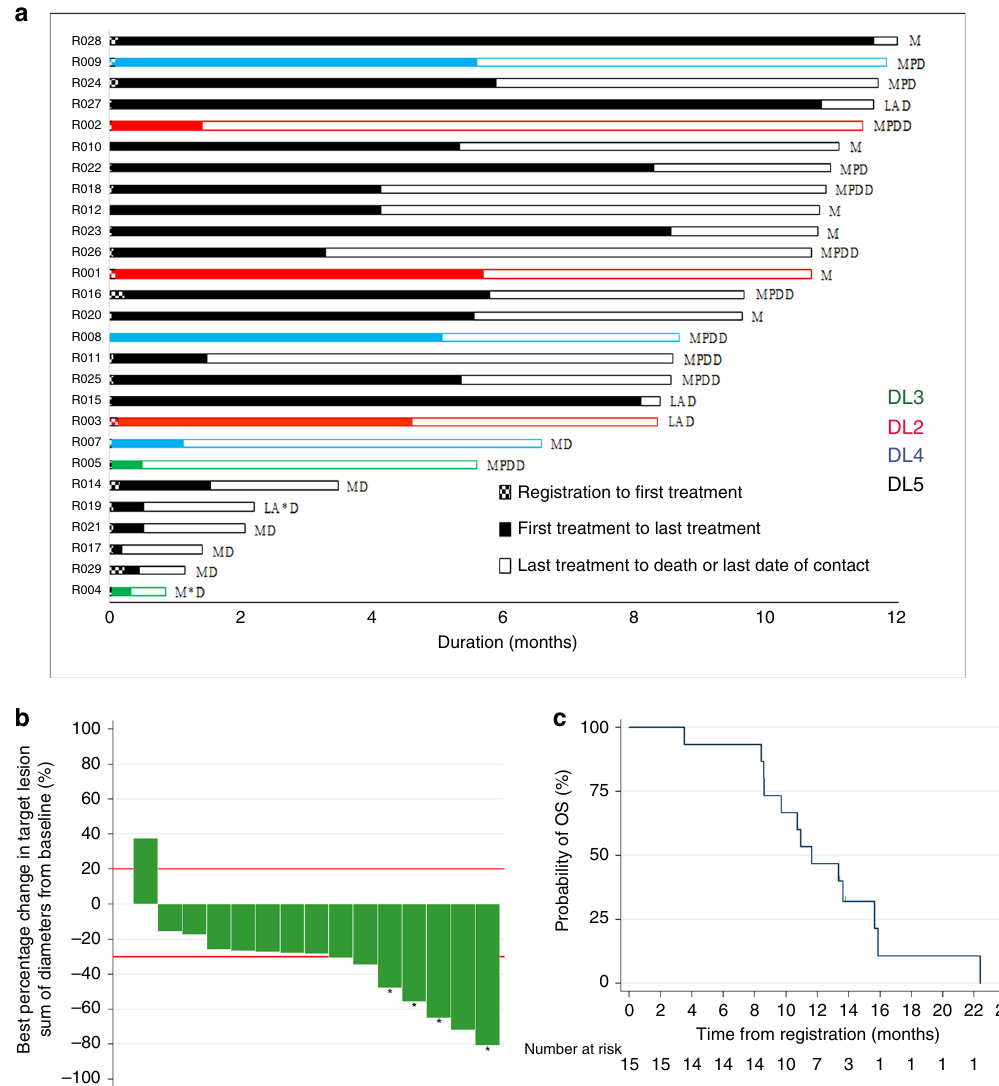
Fig. 2 Primary and secondary endpoints for STARPAC clinical trial. a Swimmer ’ s plot with color code for different dose levels (DL) and duration (months) on X -axis along with type of disease: locally advanced (LA) and metastatic (M), those who experienced DLT (*) and disease status (Death (D), progressive disease (PD)) censored at the pre-speci fi ed 12 months of starting on the trial. b Waterfall plot of best percentage change of sum of diameters in target lesion from baseline in RP2D treated patients based on an evaluable population. A positive change denotes an increase in the target lesion sum of diameters over time and, likewise, a negative change denotes a decrease in the target lesion sum of diameters over time. Reference lines added for response ( − 30% change in target lesion sum of diameters) and progression (20% change in target lesion sum of diameters). RECIST responses are marked with asterisk (*). There was progression for 6.7% (95% CI: 0.2 – 31.9%) and response in 46.7% (95% CI: 21.3 – 73.4%) of patients. c Post hoc (including data from beyond 12 months) estimated median overall survival in 15 patients receiving RP2D on evaluable population basis. Number of events = 13. Kaplan – Meier